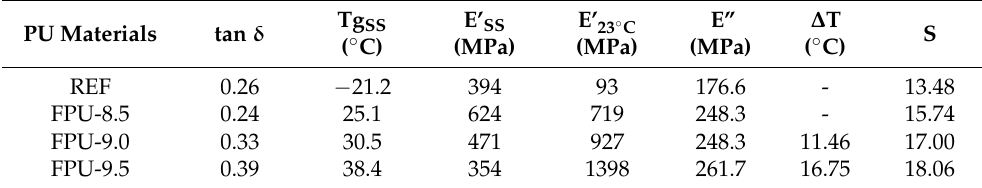
Table 3. Values of damping factor (tan δ ), the glass transition temperature of the soft segments (Tg SS ), storage modulus corresponding to this temperature (E’ SS ), storage modulus at room temperature (E’ 23 ◦ C ), the peak of the loss modulus (E”), the temperature range of efficient damping ( ∆ T) and integral area tan δ peaks (S).